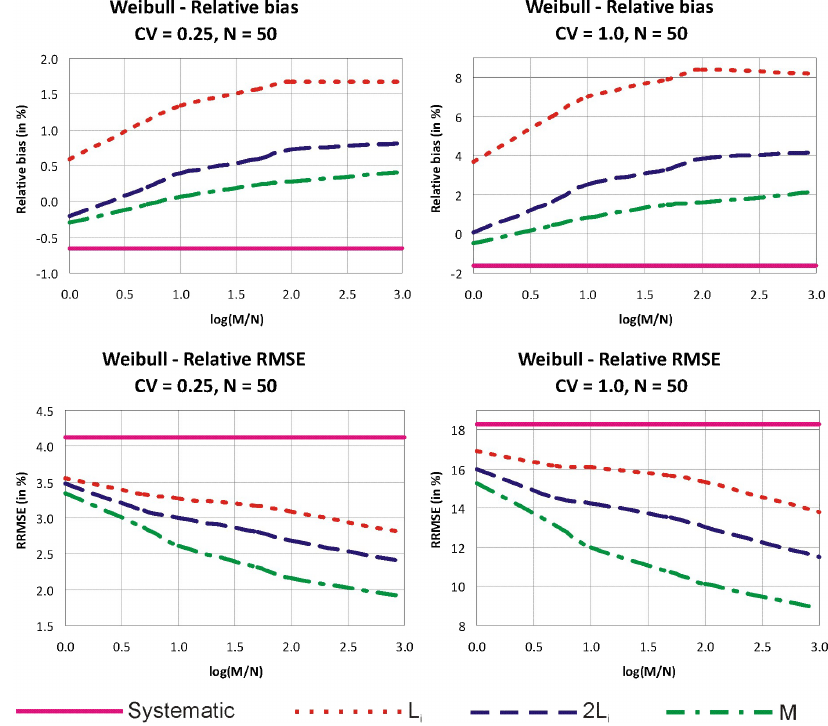
Figure 5. RB and RRMSE of ˆ X T = 100 as a function of gauge record length N and historic period M for ˆ M i = 0 , L i , 2 L i , M . Parent distribution Weibull with CV equal 0.25 and 1.0 and N = 50. Fitted distribution